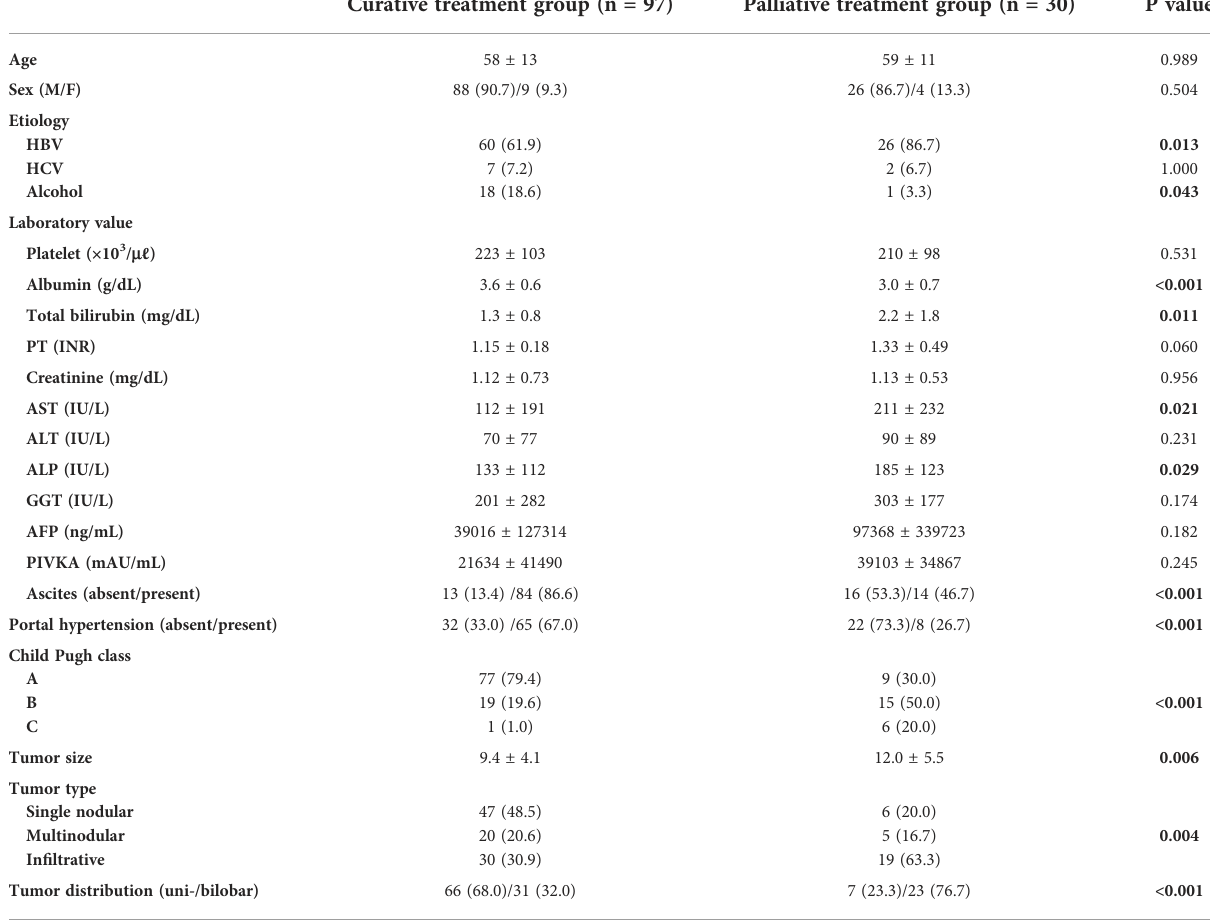
TABLE 1 Characteristics of the study sample between curative and palliative treatment